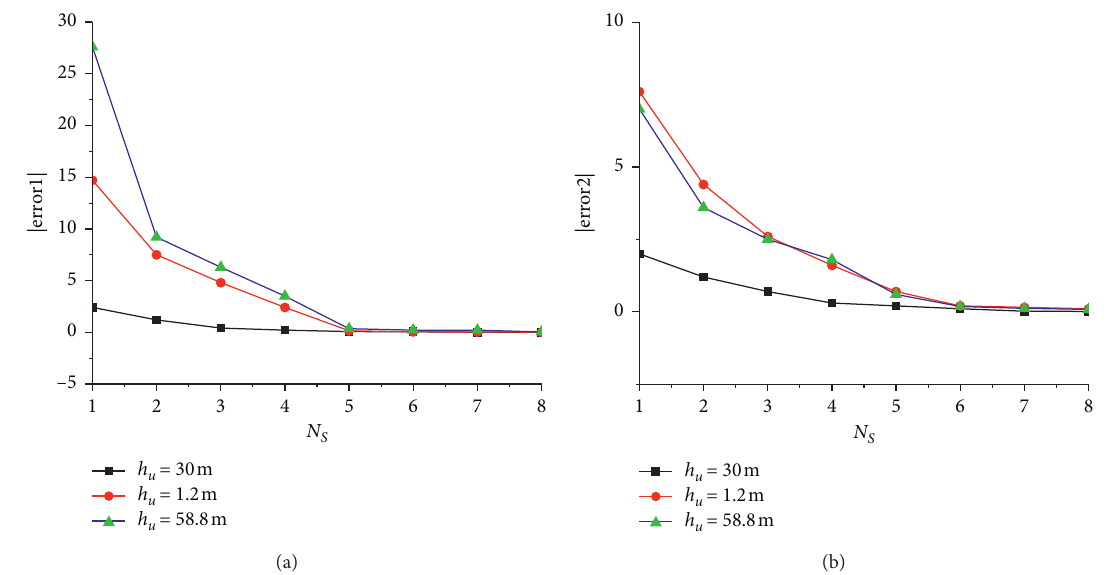
Figure 5: Average error ratios for the equivalent source intensities at different submerge depths ( f � 1600kg/m 3 and ρ 1